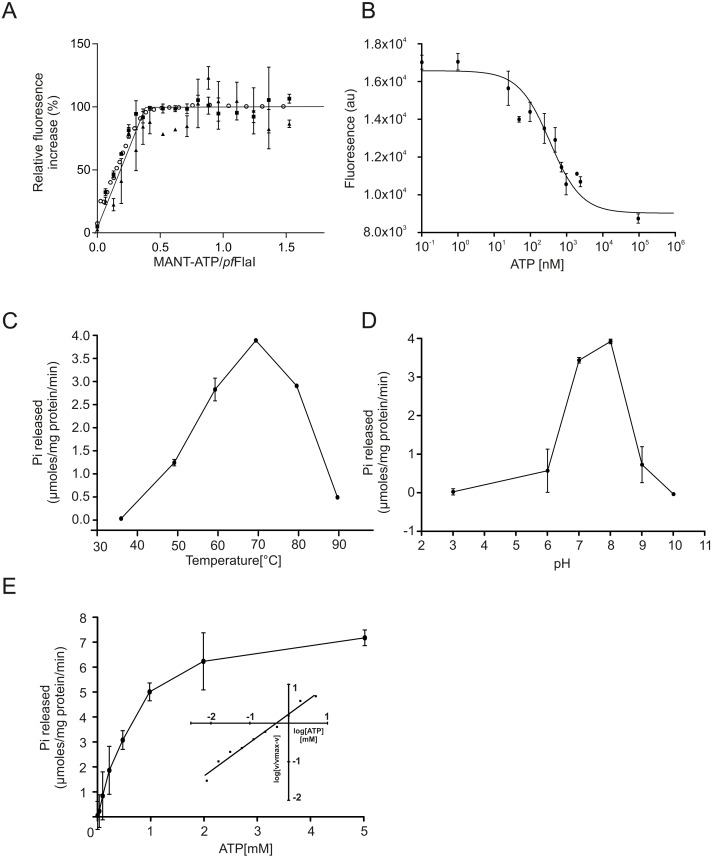
ATP binding and hydrolysis of PfFlaI.(A) Fluorescence increase at increasing concentrations of MANT-ATP upon addition of 20 nM, 100 nM and 5 µM PfFlaI. Lines depict the linear fits of the two observed phases. The lines cross at a MANT-ATP concentration of 1.7 µM. (B) Total fluorescence after addition of increasing amounts of ATP to a solution containing 20 nM PfFlaI and 10 nM of MANT-ATP. The data were fitted with the Hill equation: \documentclass[12pt]{minimal}
\usepackage{amsmath}
\usepackage{wasysym}
\usepackage{amsfonts}
\usepackage{amssymb}
\usepackage{amsbsy}
\usepackage{upgreek}
\usepackage{mathrsfs}
\setlength{\oddsidemargin}{-69pt}
\begin{document}
}{}$F=({F}_{\max }+({F}_{\min }-{F}_{\max })\ast [\text{ATP}]^{n})/({\text{IC}}_{50}^{n}+[\text{ATP}]^{n})$\end{document}F=Fmax+Fmin−Fmax∗ATPn∕IC50n+ATPn resulting in a best fit (R2 = 0.98) with IC50 = 260 nM and n = 0.67. (C, D) ATP hydrolysis by 12.5 µg/ml PfFlaI at different temperatures and at different pHs respectively. (E) ATPase activity of PfFlaI at different ATP concentrations. The curve was fitted to the Michaelis-Menten equation (V = Vmax∗[ATP]∕(Km + [ATP])), resulting in a Km of 580 nM. The inset shows the same data plotted according to the Hill equation (Hill coefficient = 0.9). Experiments were performed with at least two biological and three technical replicates. Error bars depict the standard error obtained from the technical replicates.